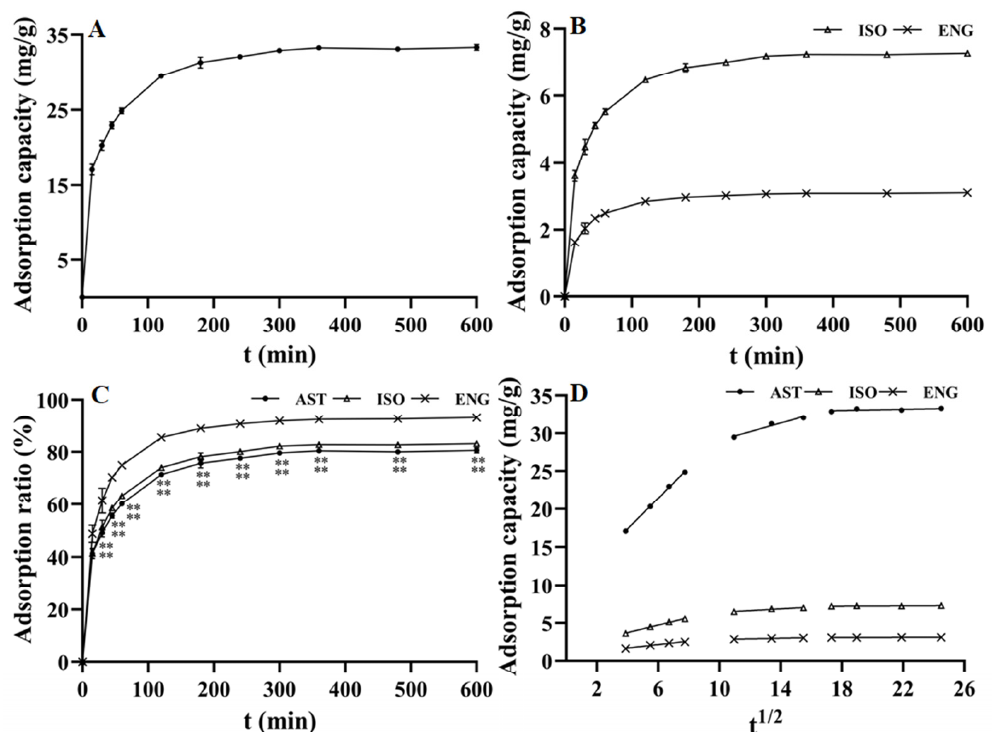
Figure 2. Adsorption kinetics curves of AST ( A ), ISO, and ENG ( B ); relative adsorption capacities in the whole adsorption process of the three flavonoids (** p < 0.01 compared with ENG) ( C ); intraparticle diffusion kinetic models of AST, ISO, and ENG ( D ). Table 1. Adsorption kinetics parameters for AST, ISO, and ENG on the HPD-300 resin.